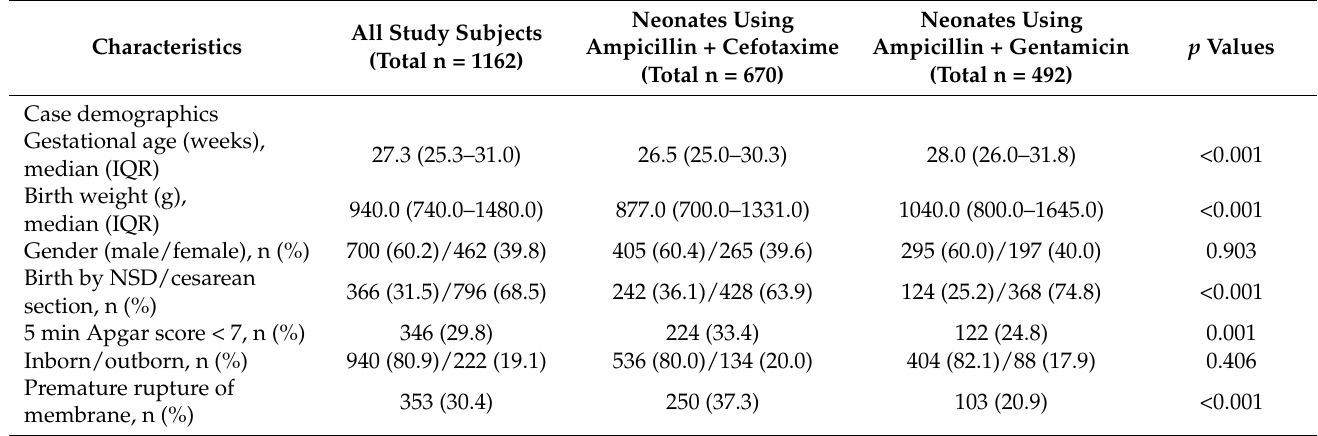
Table 1. Patient demographics, characteristics, and clinical presentation of all neonates with respira- tory